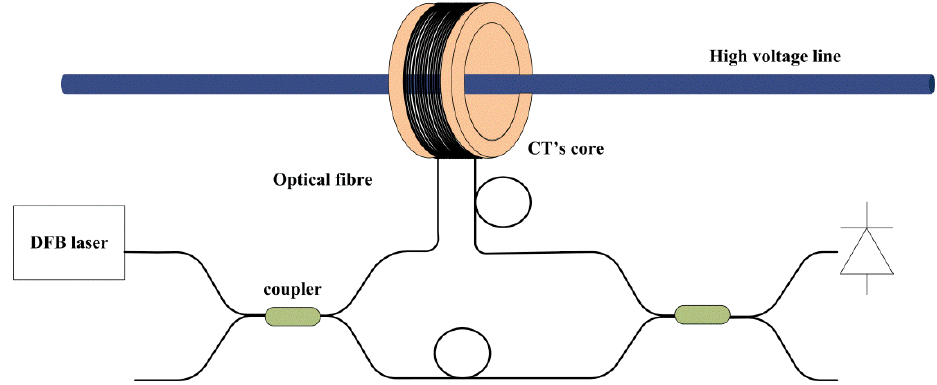
Figure 13. Experimental arrangement used for measuring electric current on high voltage systems.